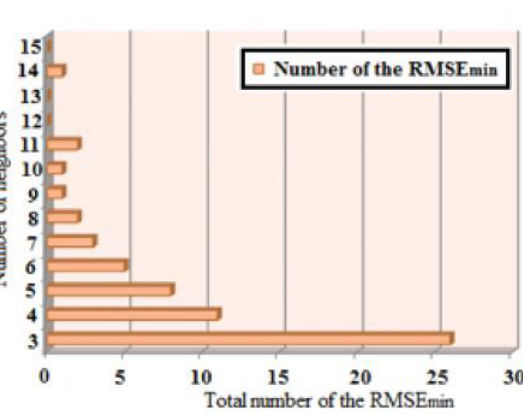
for all types min